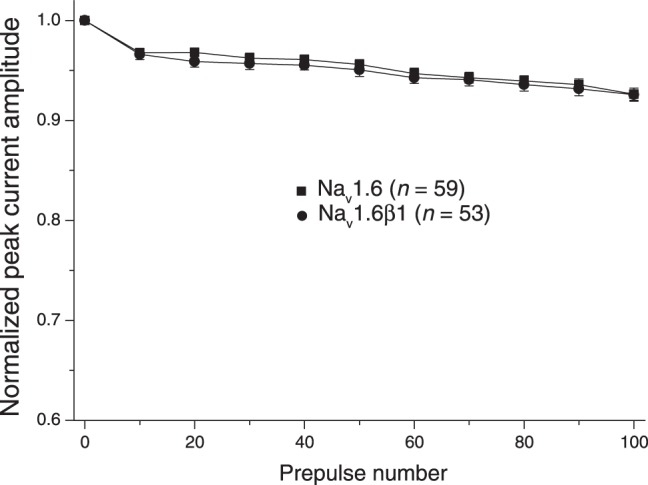
Effect of repeated depolarization on the stability of sodium currents recorded from HEK293 cells expressing Nav1.6 and Nav1.6β1 sodium channels.Sodium currents were recorded during a 40-ms step depolarization from −120 mV to −15 mV following 0–100 conditioning prepulses (5-ms pulses from −120 mV to 10 mV at 20 Hz). Currents for each cell were normalized to the amplitude of the peak current obtained prior to repeated depolarization. Values are means of the indicated number of separate experiments with different cells; bars show SE values larger than the data point symbols.